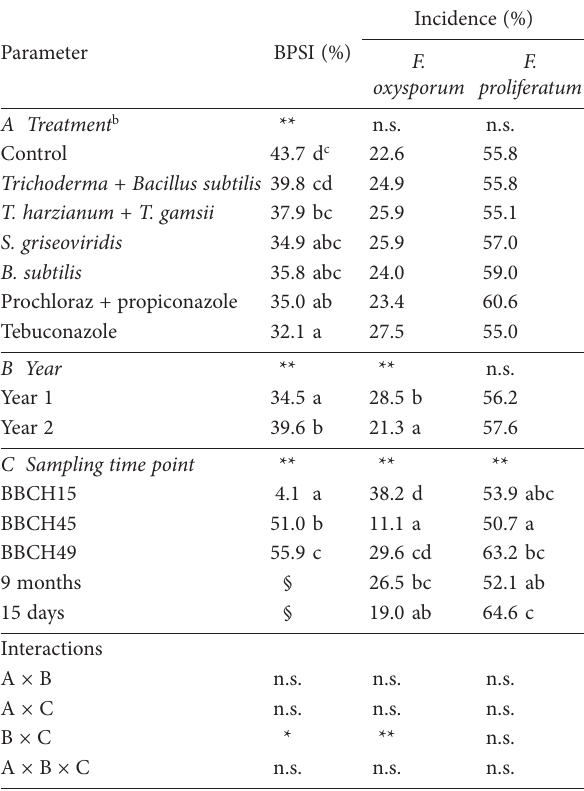
Table 3. Mean garlic bulb basal plate severity indices (BPSI), and mean incidence of fungi isolated from basal plates, for different field trial treatments, two growing seasons (Year 1, 2017–2018, and Year 2, 2018–2019), and field crop and postharvest sampling time points a